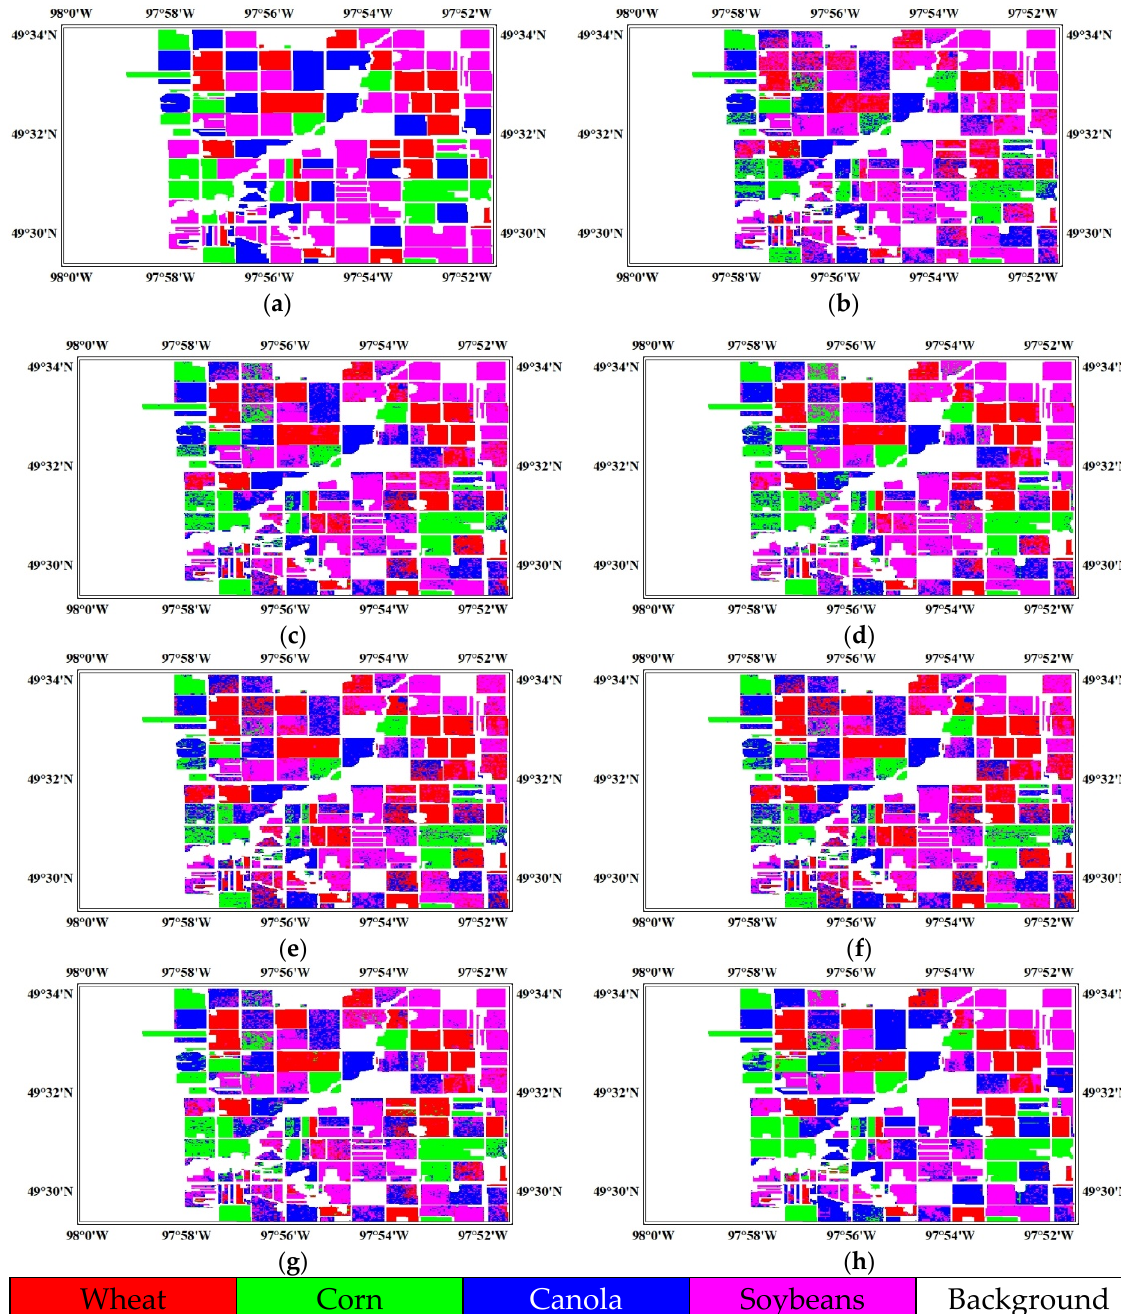
Figure 5. Ground truth map and classification maps in Winnipeg (SD: C -> TD: A), generated by different methods: ( a ) Ground truth; ( b ) DAC; ( c ) TCA+DAC; ( d ) SSTCA+DAC; ( e ) MIDA+DAC; ( f ) SMIDA+DAC; ( g ) SMbDA+DAC; ( h ) WSMbDA+DAC.